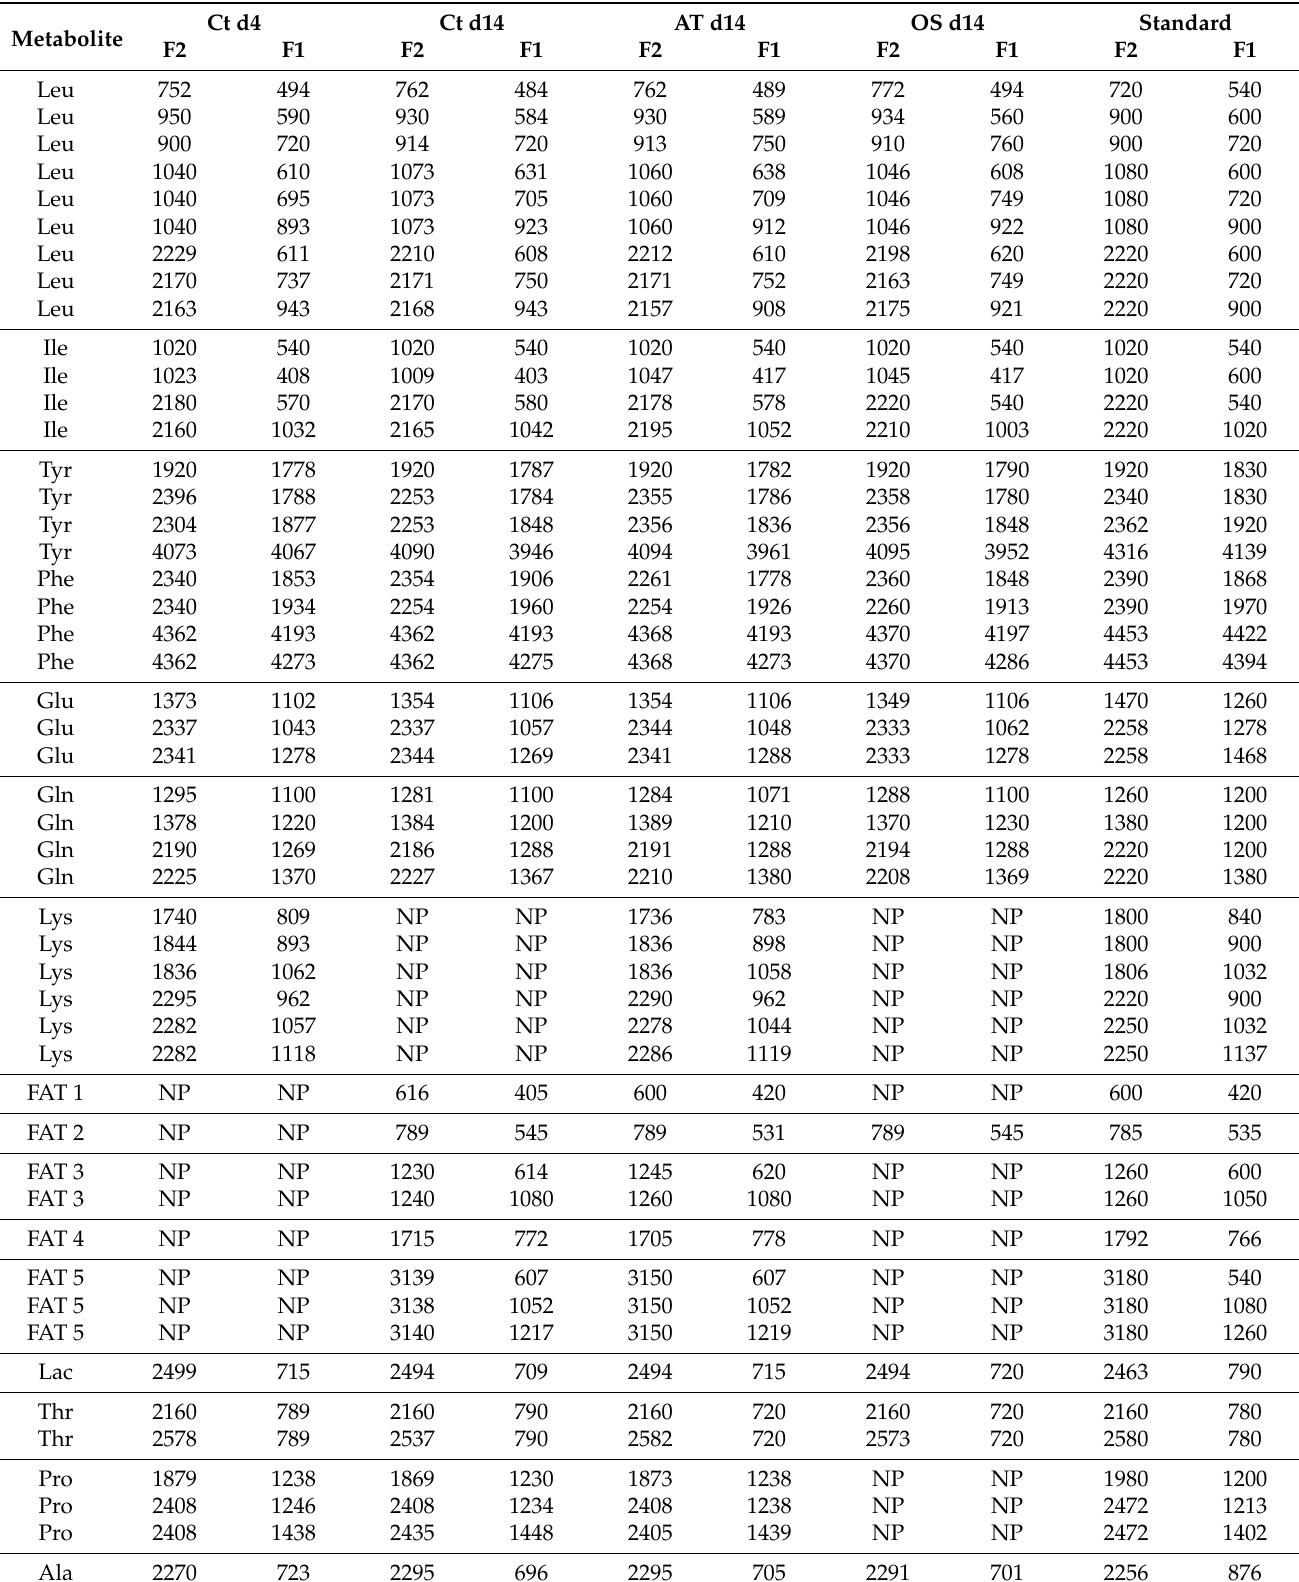
Table 1. Intracellular metabolites detected in AT-derived hMSCs. Frequencies: control group at 4 days of cultivation (Ct d4), 14 days of cultivation (Ct d14), 14 days of differentiation into adipocytes (AT d14) and osteocytes (OS d14). NP: Not